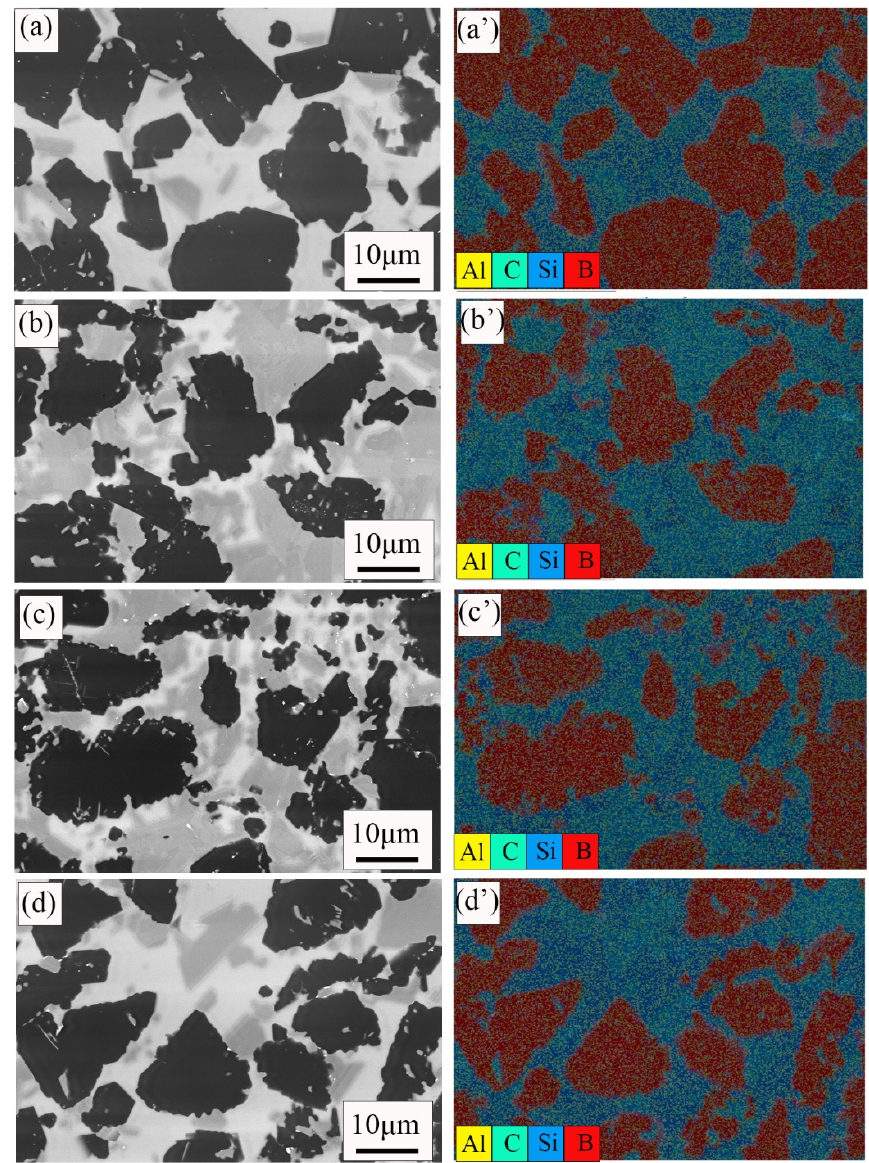
Figure 5. SEM images of the RBBC composites with different contents of carbon and EDS. ( a , a ′ ) 0; ( b , b ′ ) 5 wt%; ( c , c ′ ) 10 wt%; ( d , d ′ ) 15 wt%.